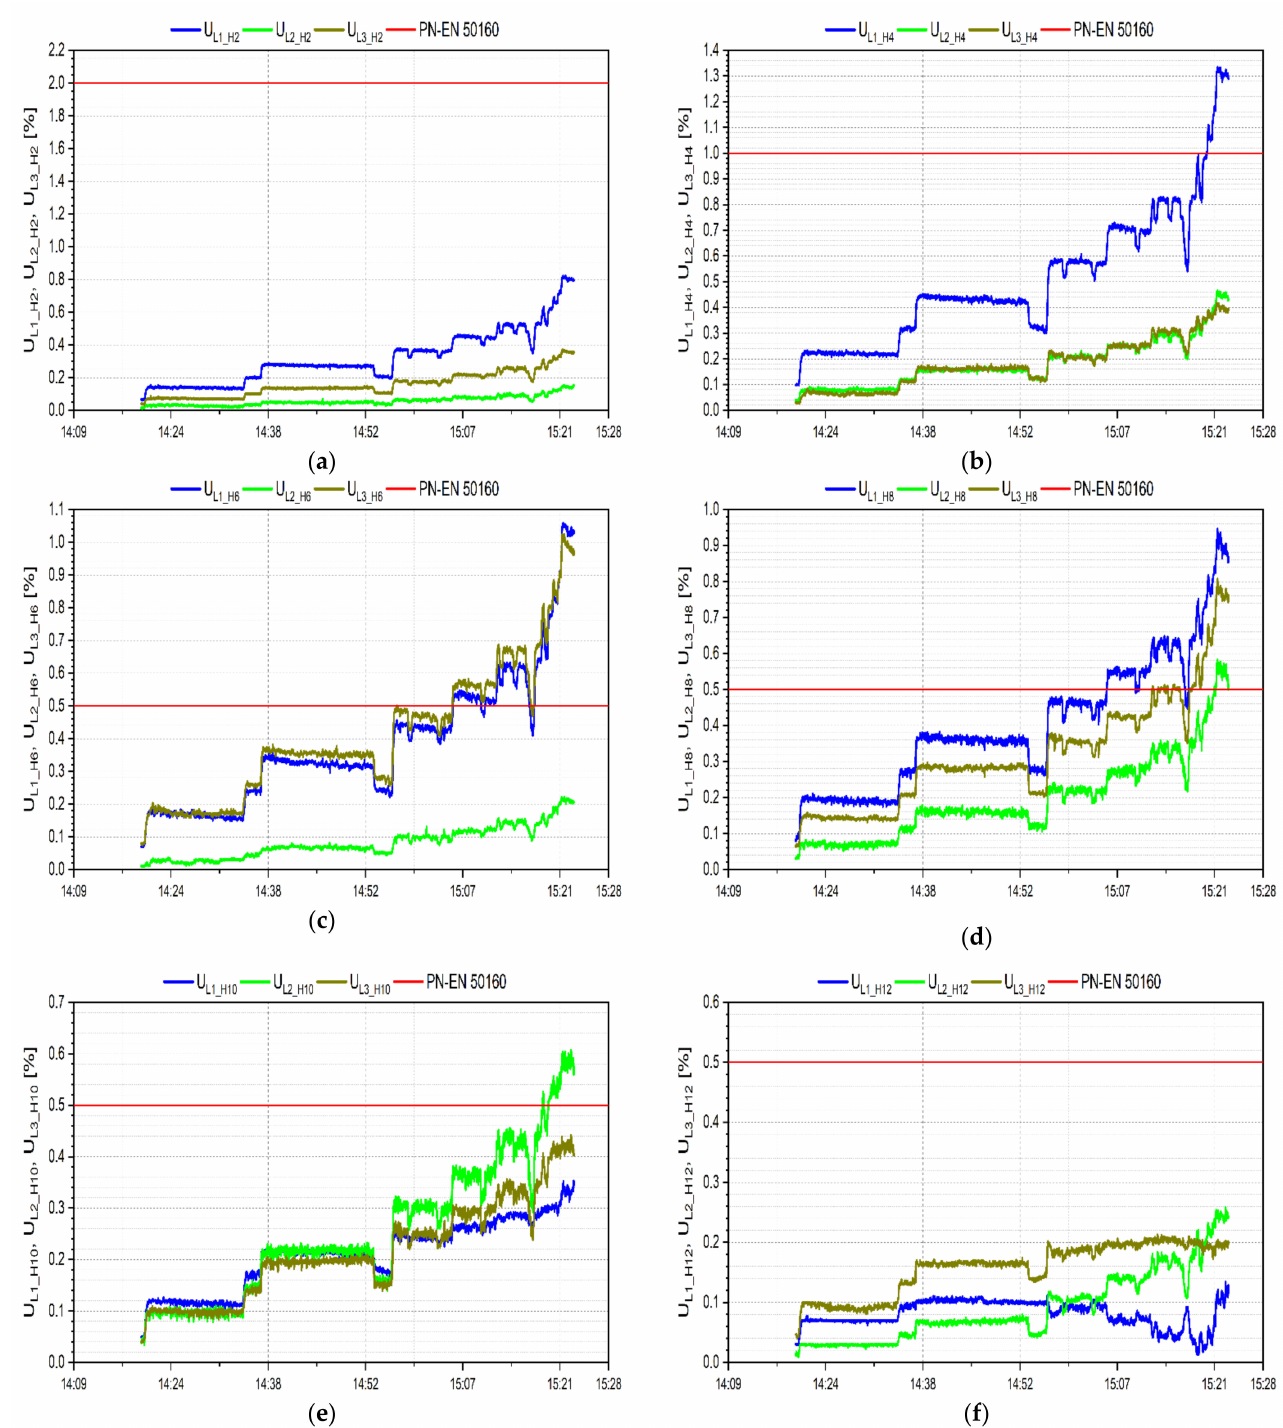
Figure 13. The individual voltage harmonic variation (150 cycles averaged): ( a ) 2nd harmonic; ( b ) 4th harmonic; ( c ) 6th harmonic; ( d ) 8th harmonic; ( e ) 10th harmonic; ( f ) 12th harmonic during the full charging